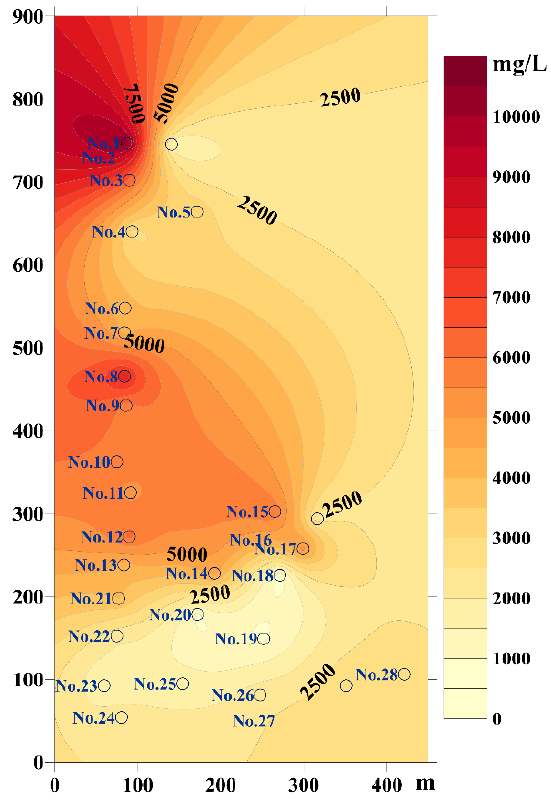
Figure 7. Locations of the 28 pumping wells and the distribution of sulfate concentrations before treatment.